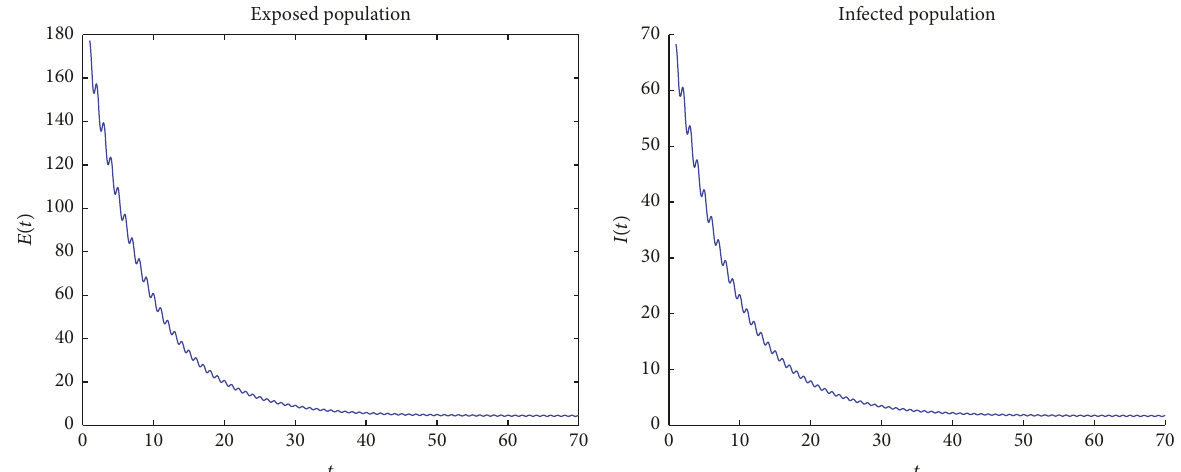
Figure 4: Solution of exposed and infected individuals of SEIRS system when R 0 > 1 . Both 𝐸 and 𝐼 remain persistent when time goes to infinity. Time 𝑡 is given in years.